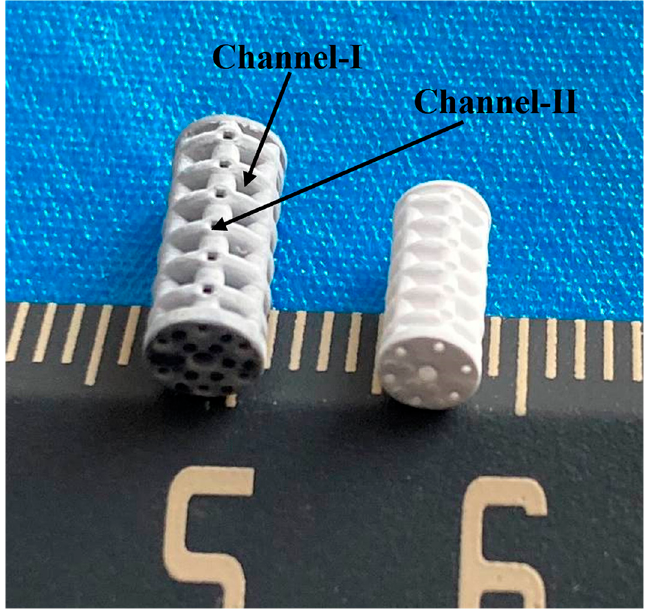
Figure 2. Photographs of β -TCP ceramic scaffolds (hollow scaffolds) fabricated for impregnation by DLP process ( left : green scaffolds, right : sintered